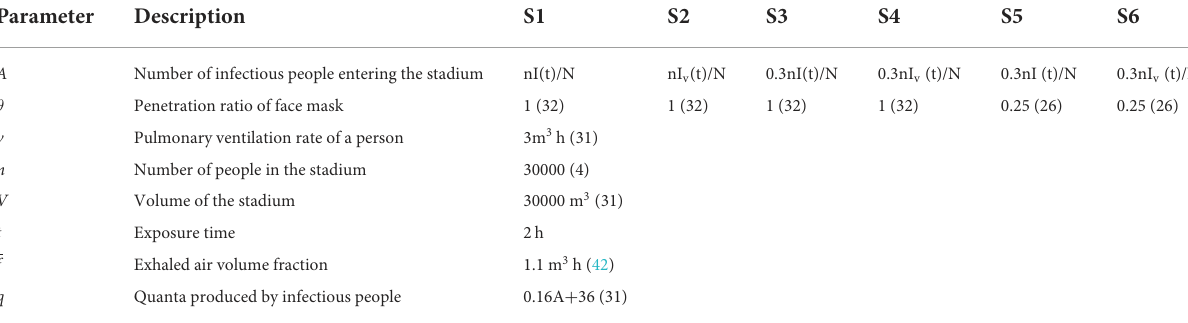
with vaccination, which decreased progressively from 20 April to 10 September in accordance with the curve of I v